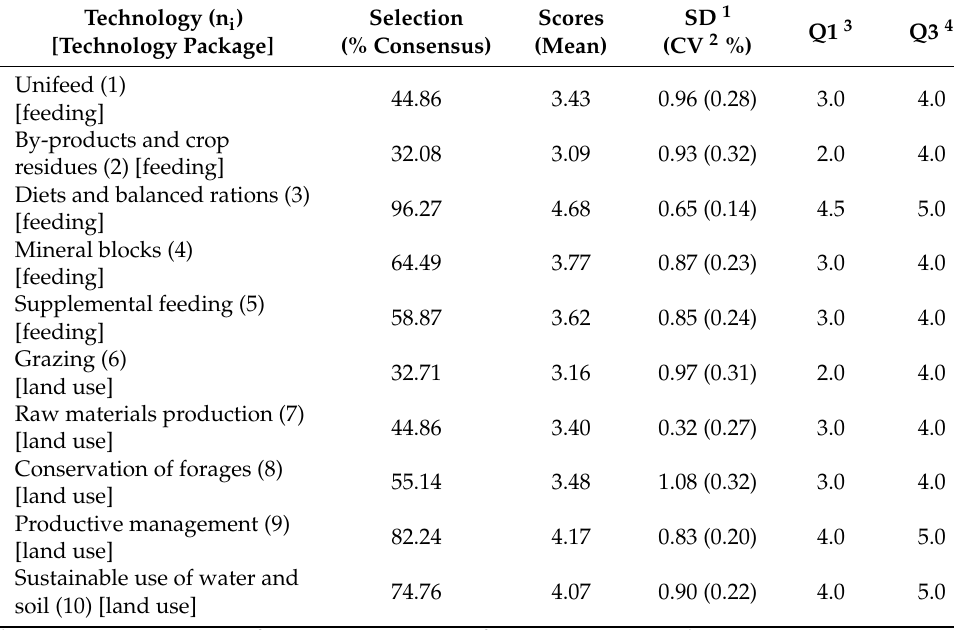
Table 1. Selection of feeding and land use technologies (points).